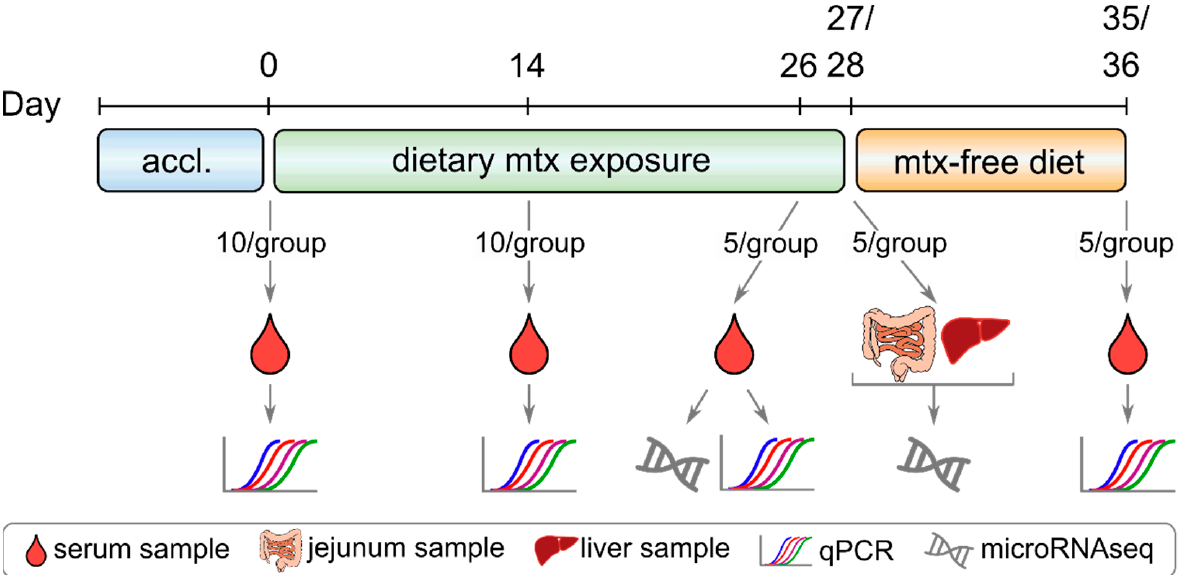
Figure 1. Sample collection scheme. Sample types, days of sampling and analyses performed are shown (accl.: acclimatization phase; mtx: mycotoxin).